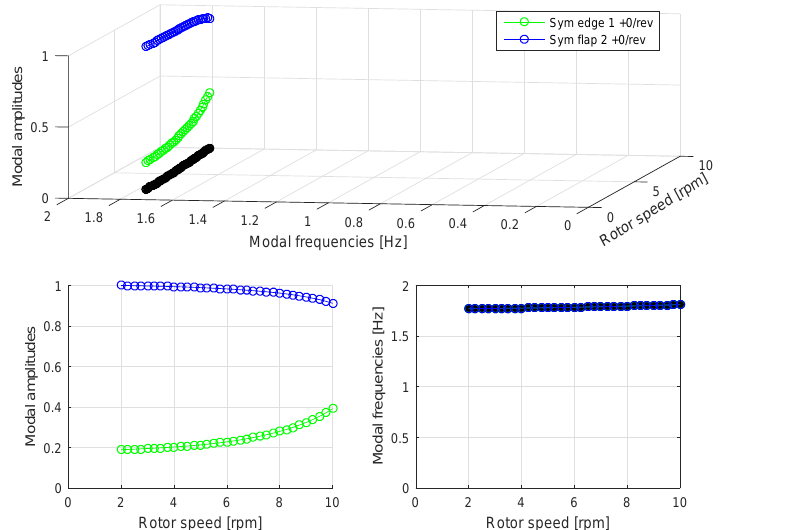
Figure 14. Harmonic modal components for the mode dominated by symmetric deflection of the rotor in the second flapwise mode. Plot layout as in Fig. 5.